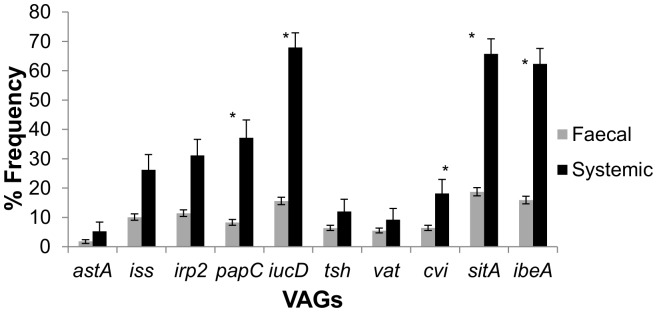
Comparison of faecal and systemic E.
coli VAG carriage.Upper and lower bound 95% confidence intervals indicate statistically significant differences between VAG carriages by the two populations. Fisher's exact test indicates that irp2, papC, iucD, cvi, sitA and ibeA are significantly more associated with systemic E. coli (p<0.05) denoted in figure by *.